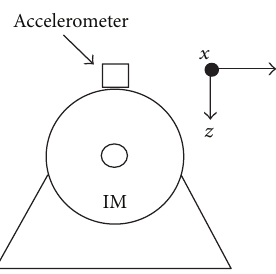
Figure 5: Accelerometer placed on induction motor.